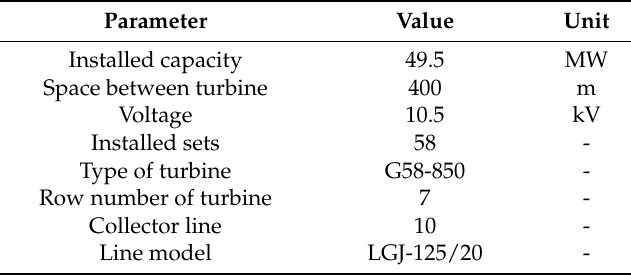
Table 1. The parameters of WPP.